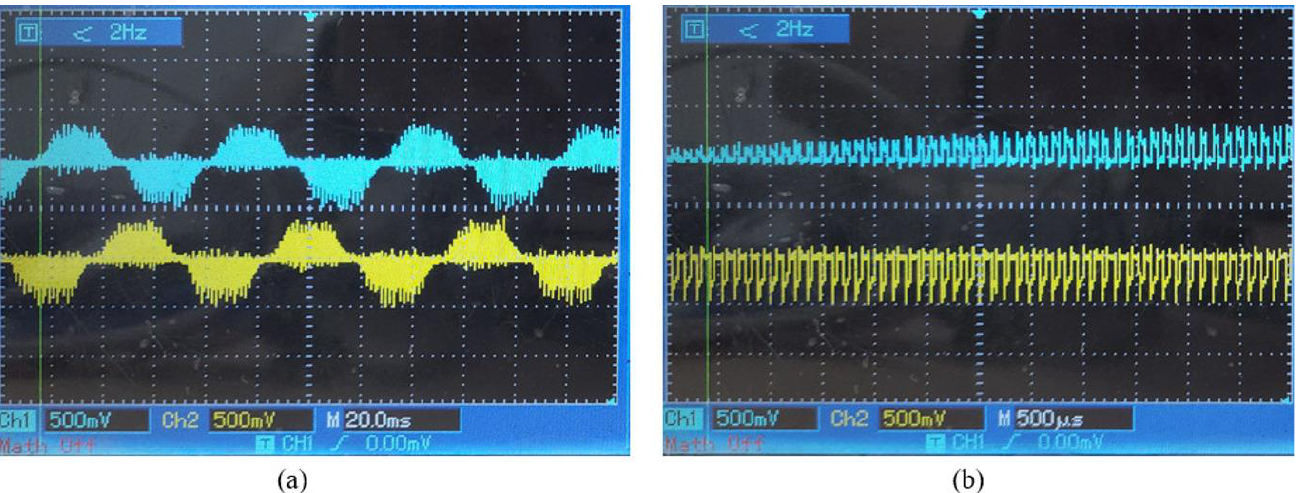
Figure 20. The wave of the BLDC motor’s current feedback; ( a ) 20 ms scale waveform; ( b ) 500 us scale waveform.